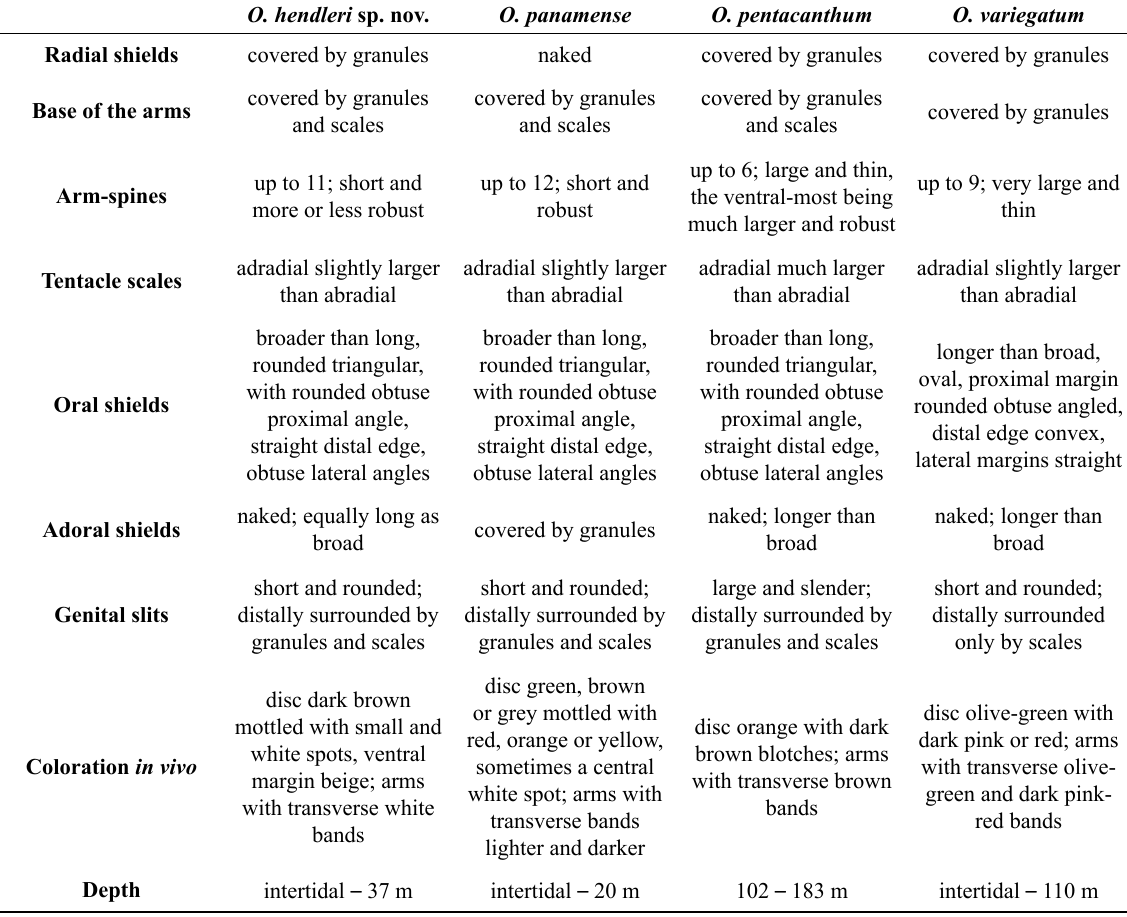
Table 1. Comparison of morphological characters between some species of Ophioderma from the Eastern